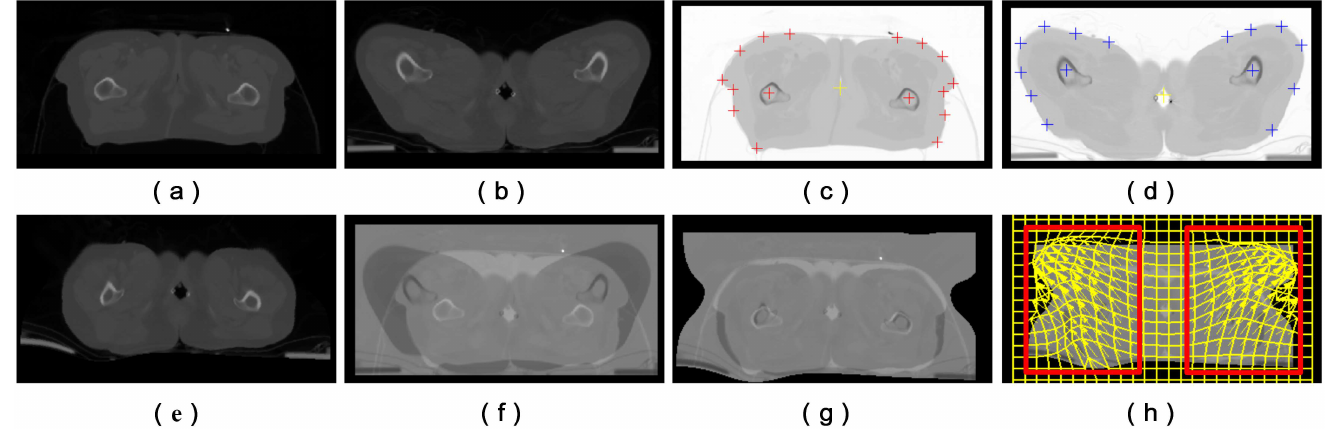
Fig 5. Correction of locally large deformation between EBRT and HDR-BT images by LFFD. (a) EBRT images used as a reference. (b) HDR-BT image with locallylarge deformationinducedby the brachytherapy applicator.(c) and (d) Corresponding EBRT and HDR-BT image with manual landmarks. (e) HDR-BT image after correction of locallylarge deformation by LFFD. (f) and (g) Corresponding difference images before and after correction. (h) Deformation grid of LFFD, in which the ROIs are definedby the red rectangles.